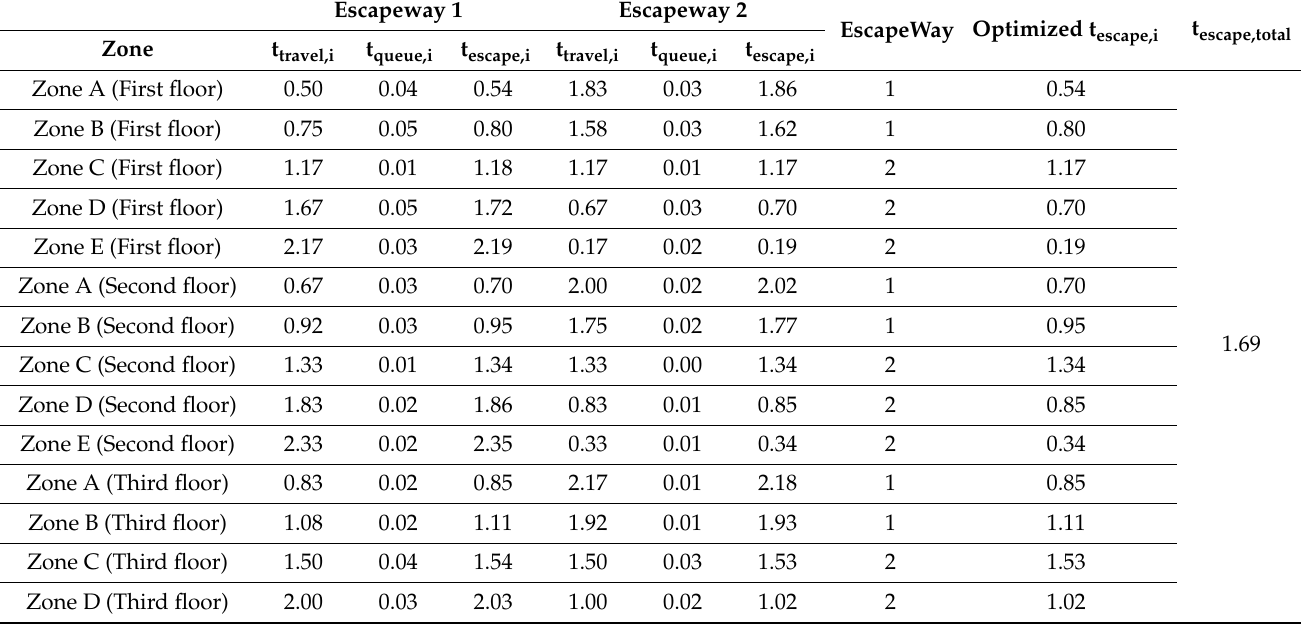
Table 5. Escape route optimization results of the proposed